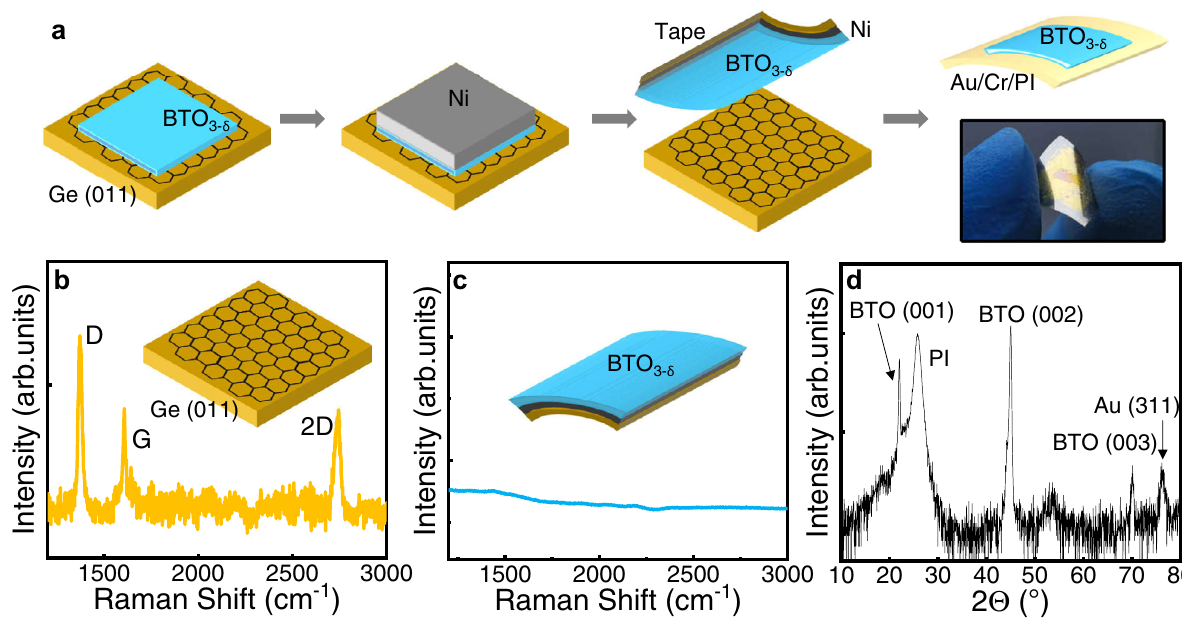
Fig. 4 Exfoliation and transfer of the BTO 3- δ fi lm on a fl exible PI substrate. a Schematic illustration of the BTO 3- δ fi lm growth, exfoliation, and transfer process onto a fl exible PI substrate. Raman spectra of b the Ge (011) surface and c the exfoliated fi lm surface. d Specular XRD pattern of the BTO 3- δ fi lm transferred onto a fl exible PI